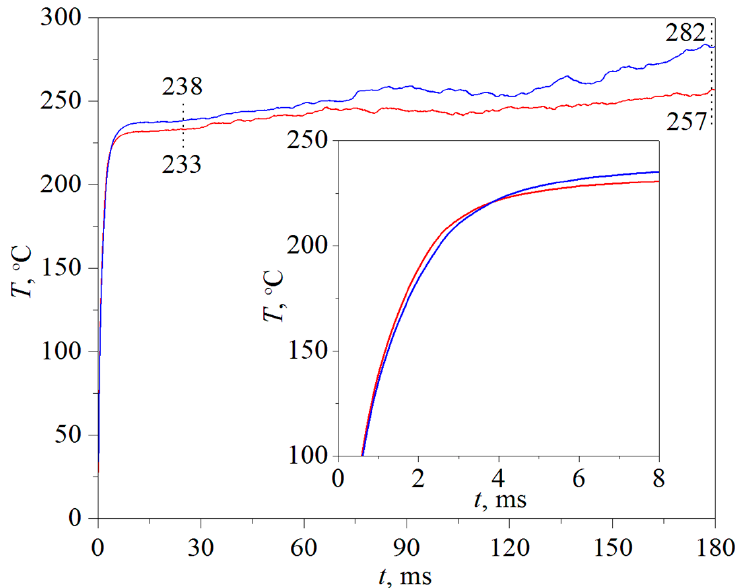
Figure 7. Heating curves for a mixture containing 30 wt.% PPG-425 in the mode of constant power;